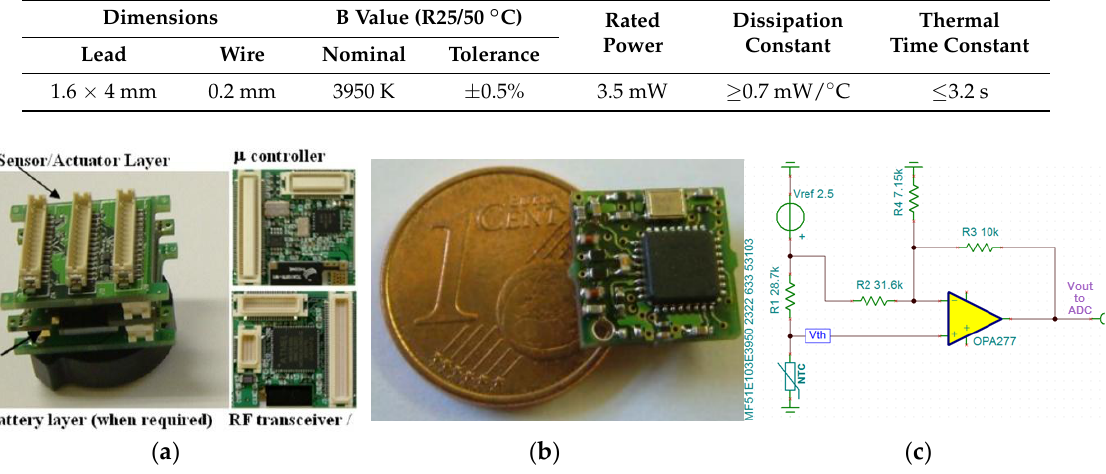
Table 2. Thermistor specifications [31].